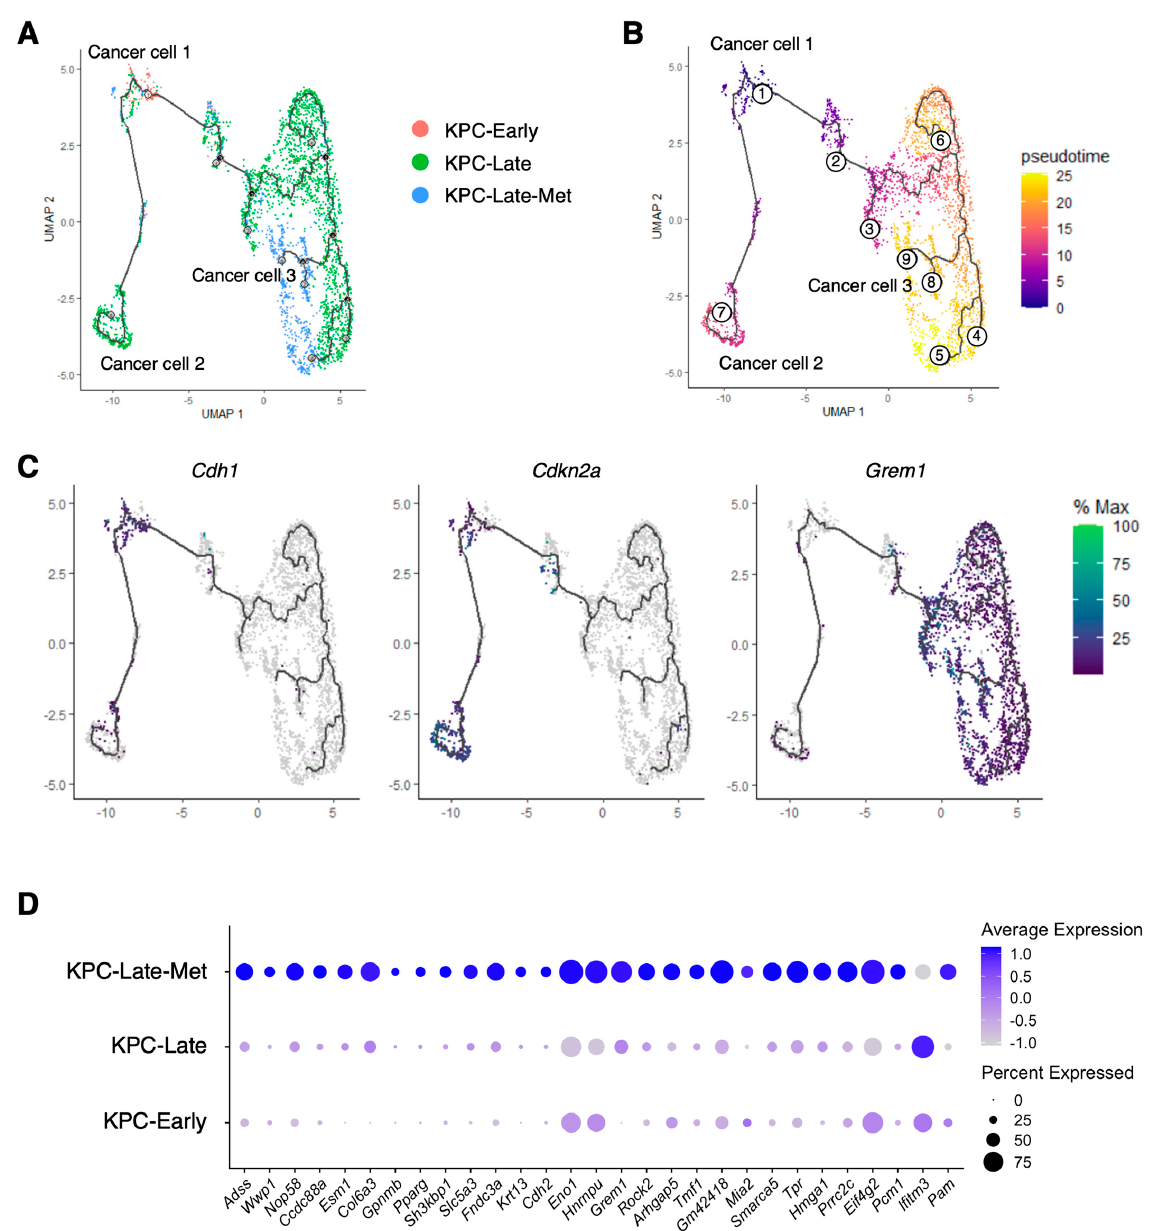
Figure 3. Liver metastases reveal different trajectories of cancer cell subpopulations from primary tumors. ( A – C ) Pseudotime trajectory of cancer cell subpopulations, as revealed by the Monocle3 inference analysis. The distributions of cancer cell subpopulations among KPC-Early, KPC-Late, and KPC-Late-Met groups are compared in ( A ). The transitional trajectory of cell subpopulations (defined by Monocle3 as the pseudotime clusters 1–9) is shown in ( B ). Cluster 1 in this Monocle3 trajectory plot represents the previously defined cancer cell CC-1 subcluster as the starting point of the pseudotime trajectory. Cluster 2 represents the previously defined CC-2 subcluster. Clusters 3–9 represent the previously defined CC-3 subcluster. The expression profiles of representative genes for the previously defined CC-1, CC-2, and CC-3 are shown in ( C ). ( D ) Differentially expressed genes (DEGs) were calculated by comparing cancer cells from liver metastasis with cancer cells from matched primary tumors. The metastasis-upregulated genes were defined as the DEGs that were expressed by cancer cells of liver metastases at significantly higher levels than cancer cells of late-stage primary tumors. The expression profiles of indicated metastasis-upregulated genes are shown in dot